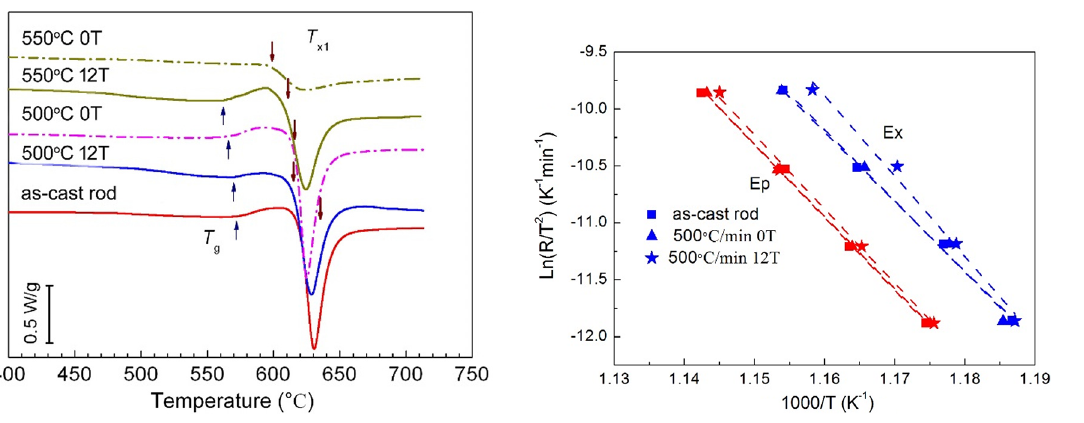
Figure 2. Kissinger plots of the start and peak temperatures for the primary crystallization for